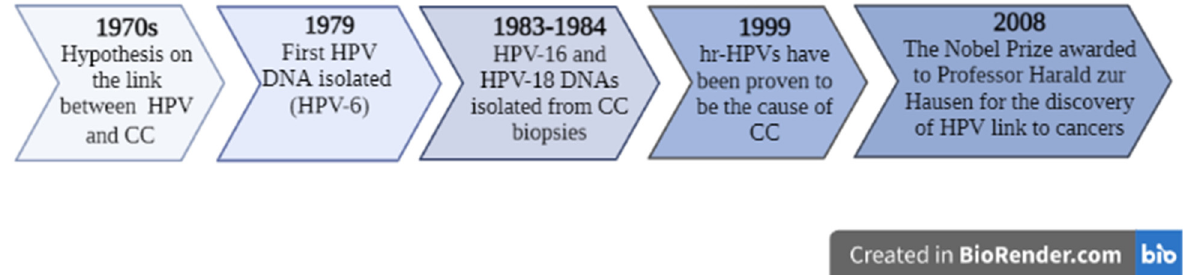
Figure 1. Establishing the link between HPV and cancers. Figure legend: HPV—human papilloma ‐ virus; CC—cervical cancer. mavirus; CC—cervical